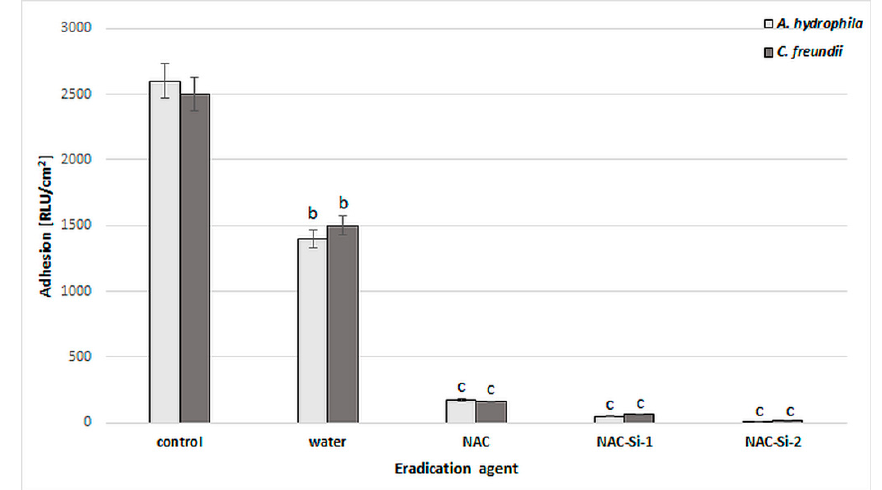
Figure 6. Effects of water, NAC and polymers NAC-Si-1 and NAC-Si-2 on eradication of biofilms formed by A. hydrophila and C. freundii . Results after 1 h treatment compared to that of the control sample (10-day biofilm without NAC or polymer derivatives). Values show the mean ± standard deviation (SD, n = 3). Values with different letters are statistically different: b, 0.005 < p < 0.05; c, p < 0.005.